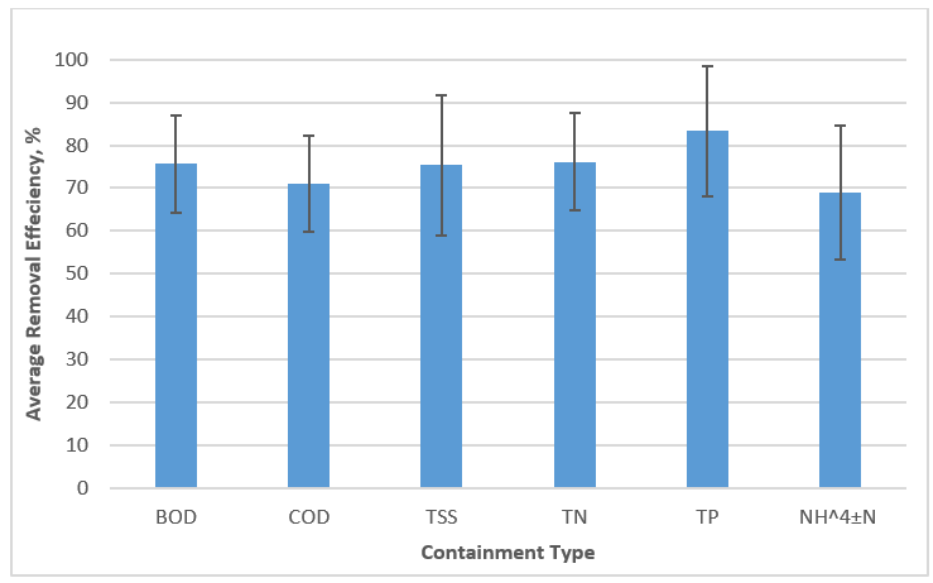
Figure 5. Vertical flow lab scale systems removal efficiency.